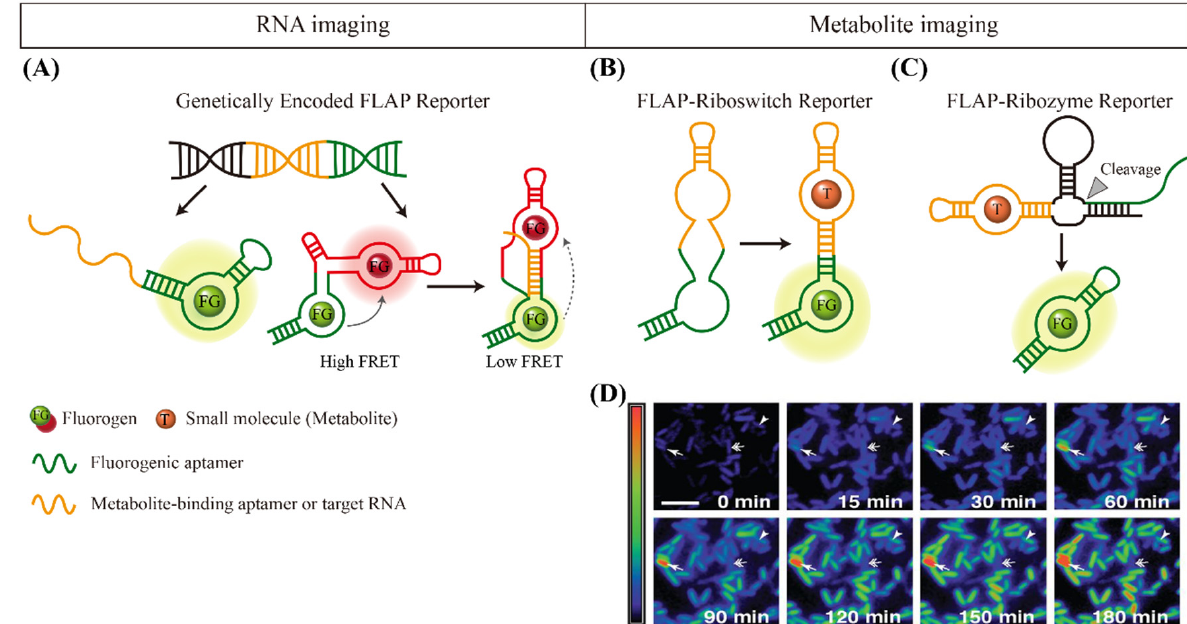
Figure 3. Schematic overview of FLAP reporters for imaging endogenous RNAs or metabolites in living cells. ( A ) Genetically encoded FLAP reporters for imaging RNAs. ( B ) FLAP-riboswitch reporters for imaging small targets. ( C ) FLAP-ribozyme reporters for imaging small targets. ( D ) Time-lapse FL imaging of SAM in living bacteria using RNA aptamers, exhibiting dynamic changes in the endogenous levels of SAM; fast increase (arrow), slow increase (arrowhead), or early increase/late decrease (double arrow). Scale bar, 5 μ m. The image is adapted from [81] . In FLAP reporters, RNA aptamers recognize their cognate FG that are minimally fluorescent, leading to a strong FL intensity with different colors. This process is known to be resistant to fluorophore maturation and photobleaching. FLAP, fluorescent light-up aptamer (or fluorogen-activating aptamer). SAM, S-Adenosyl- L -methionine. Table 1. List of FLAPs for Imaging RNAs or endogenous metabolites in living cells. RNA Sequence (5 ′ to 3 ′ ) Aptamer